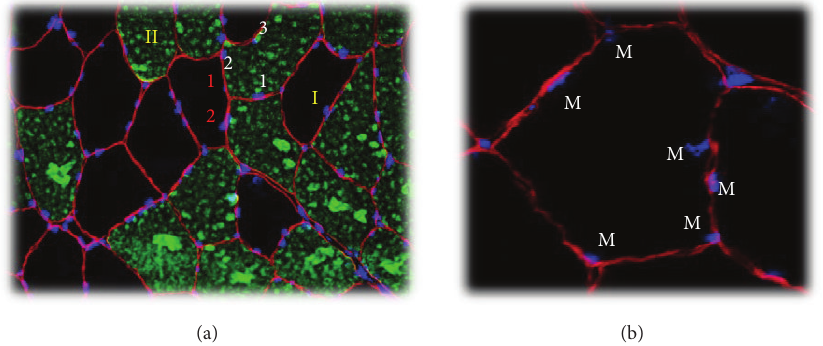
Figure 7: Counting myonuclei. (a) Biopsy marked with dystrophin (red stain), MHC II (green stain), and DAPI (blue stain). Roman numerals indicate fiber types I and II. Red numbers mark myonuclei in type I fibers and white numbers for type II fibers. (b) Blue stain: DAPI (myonuclei) and red markings: dystrophin. Myonuclei branded with M were determined to have their geometric center (nucleus center) inside the dystrophin